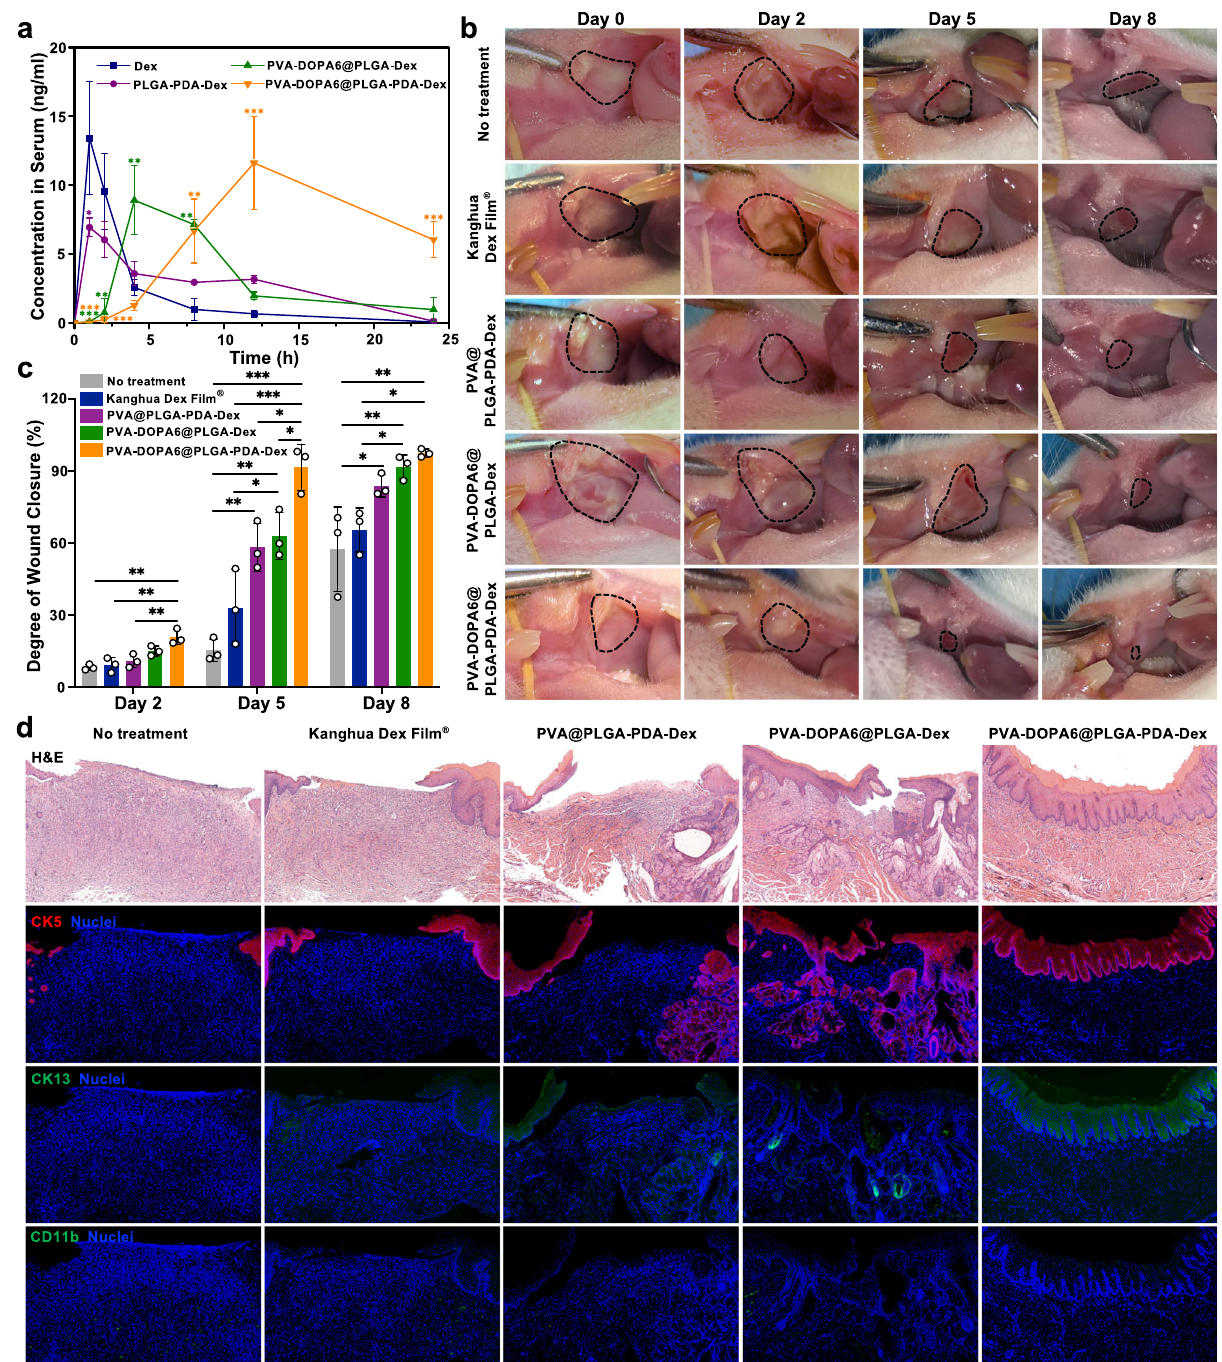
Fig. 8 In vivo pharmacokinetic study and therapeutic ef fi cacy of the PVA-DOPA@NP fi lm in oral ulcers. a Variation in plasma Dex concentration as a function of time after application of different formulations via the buccal or oral route. Dex: dexamethasone, PVA: poly(vinyl alcohol), DOPA: 3,4- dihydroxy-D-phenylalanine, PLGA: poly(lactic-co-glycolic acid), PDA: polydopamine. * P = 0.022; ** P < 0.01; *** P < 0.001 vs Dex group. b Gross inspection of b uccal mucosa ulcers in Sprague Dawley rats treated with Kanghua Dex Film ® , PVA@PLGA-PDA-Dex, PVA-DOPA6@PLGA-Dex, PVA-DOPA6@PLGA- PDA-Dex fi lm, and no treatment at days 0, 2, 5 and 8 (Group 1). c Degree of wound closure of the oral ulcers at days 0, 2, 5 and 8. * P < 0.05; ** P < 0.01; *** P < 0.001. d Hematoxylin and erosion (H&E) staining and immunohistochemical staining with anti-cytokeratin 5 rabbit monoclonal antibody (CK5, red), anti-cytokeratin 13 rabbit polyclonal antibody (CK13, green), and CD11b polyclonal antibody (CD11b, green) in regenerated oral ulcers at day 8. Nuclei (blue) were stained with DAPI (Group 1). Scale bar: 100 μ m. All data are Mean± S.D. n = 3 animals per group. Statistics was calculated by one-way ANOVA followed by Tukey ’ s post-test. Exact P values are given in the Source Data fi le. Source data are provided as a Source data fi